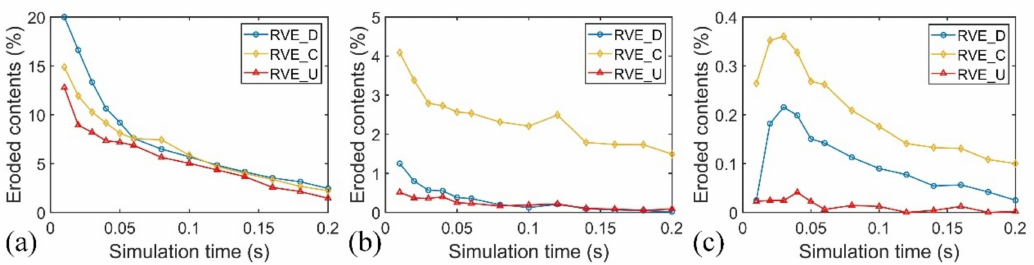
Figure 7. Evolution of eroded contents for specimen ( a ) FC30; ( b ) FC40; and ( c ) FC60.